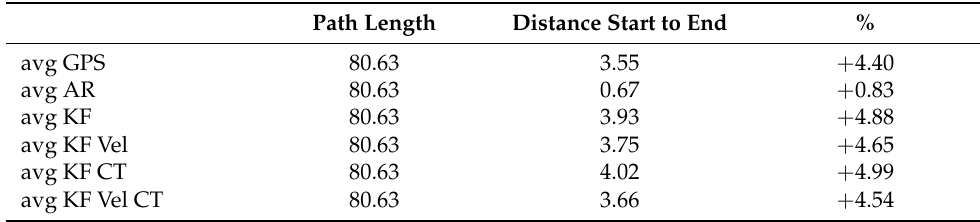
Table 3. Evaluation (Dataset 1): GPS and AR; distance between the start and end.